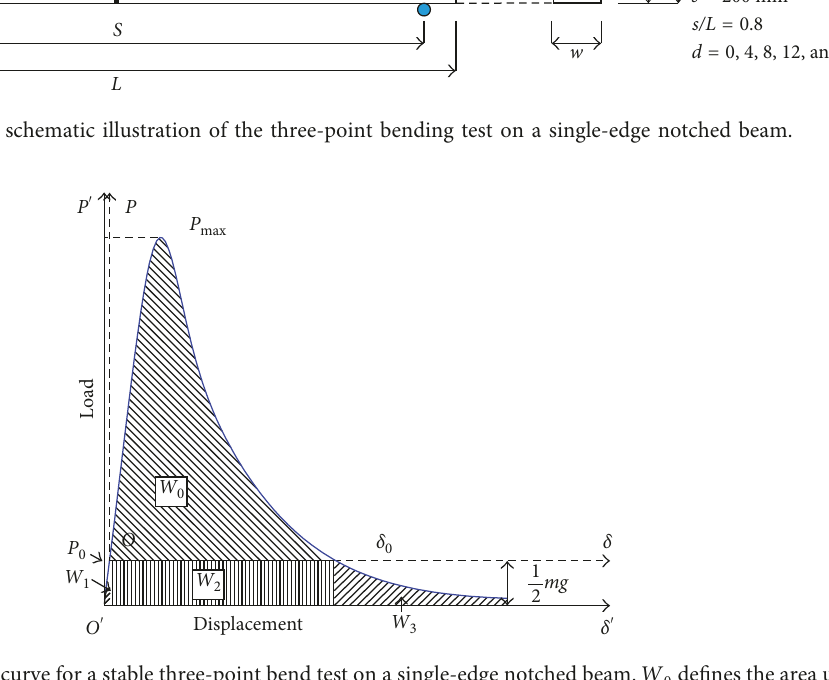
0 defines the area under the load-